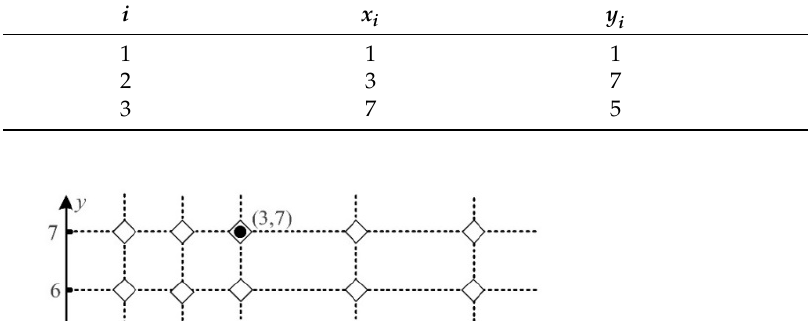
Table 3. Data for the example with three demand points.